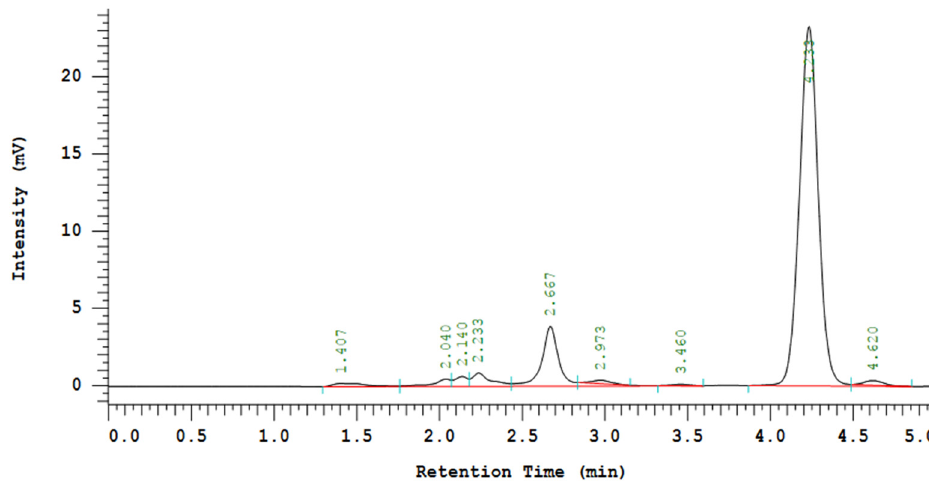
Figure 2: HPLC peak of isolate compound “ Atropine.